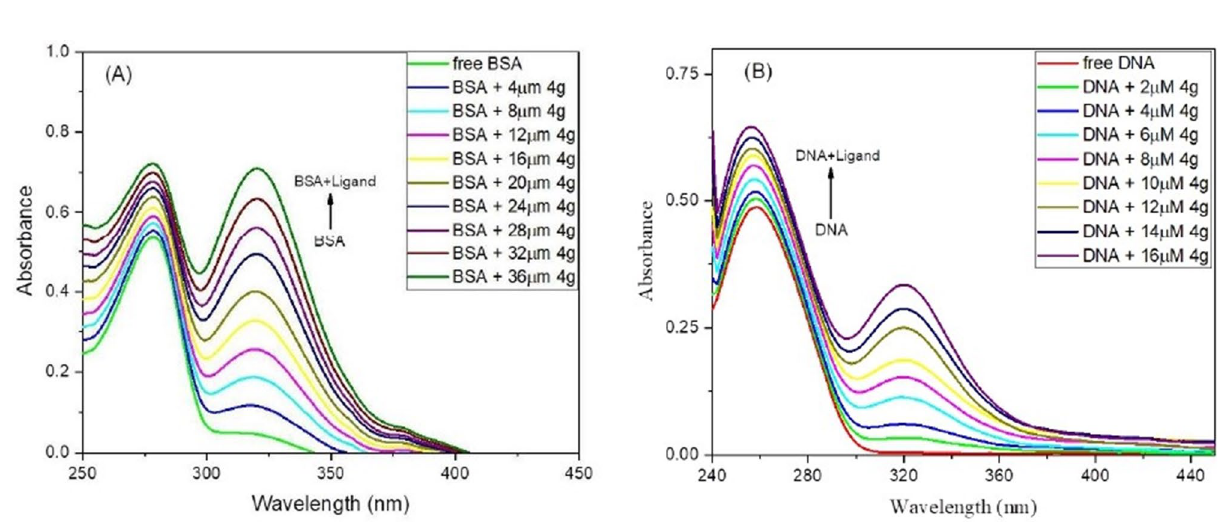
Figure 8. ( A) UV–visible spectra of BSA-ligand complex system at increasing concentrations of 4g (0–36 µM) at constant BSA concentration of 15 µM ( B ) Absorption spectra of ct-DNA- 4g complex at a varying concentration of 4g (0–16 µM) by keeping the concentration of DNA constant at 72 µM in physiological pH 7.2 of Tris–HCl buffer at room